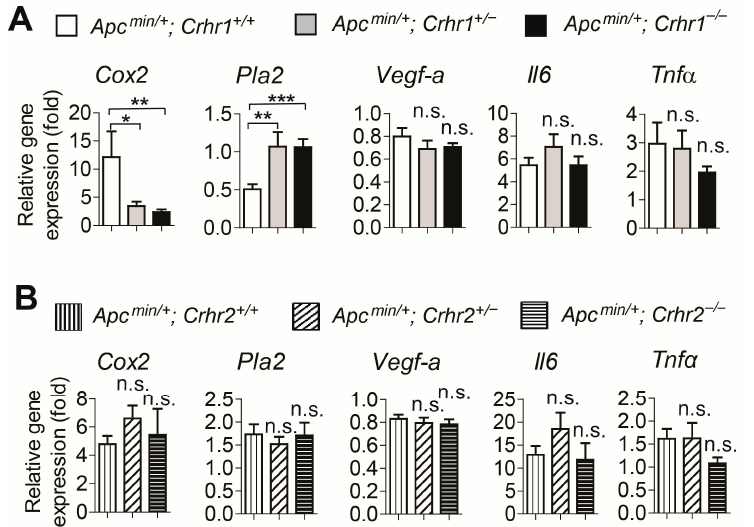
Figure 4. Crhr1 deletion alters the expression of Cox2 and Pla2 in the tumors developed in Apcmin/+ mice. ( A , B ) The mRNA levels of cancer-associated genes, including Cox2 , Pla2 , Vegf-a , Il6 , and Tnf α , were evaluated by performing qPCR. Using tumor tissues isolated from the small intestine, total RNA was isolated to carry out qPCR, and the mRNA level of each gene in the tumor tissues was measured. In addition, total RNA of normal intestinal tissues from Apcmin/+; Crhr1 +/+ mice ( A ) or from Apcmin/+; Crhr2 +/+ mice ( B ) was also isolated. With qPCR, the mRNA level of each gene in the normal tissues was measured. The level of normal tissues was set as ‘1’. To this value, the mRNA level of each gene from the tumor tissues was then compared to calculate the relative gene expression in a fold unit. Presented are the accumulated data of three independent experiments. Error bars indicate ± SEM. * p < 0.05, ** p < 0.01, *** p < 0.001, n.s. stands for not significant (one-way ANOVA, n = 11–16 per